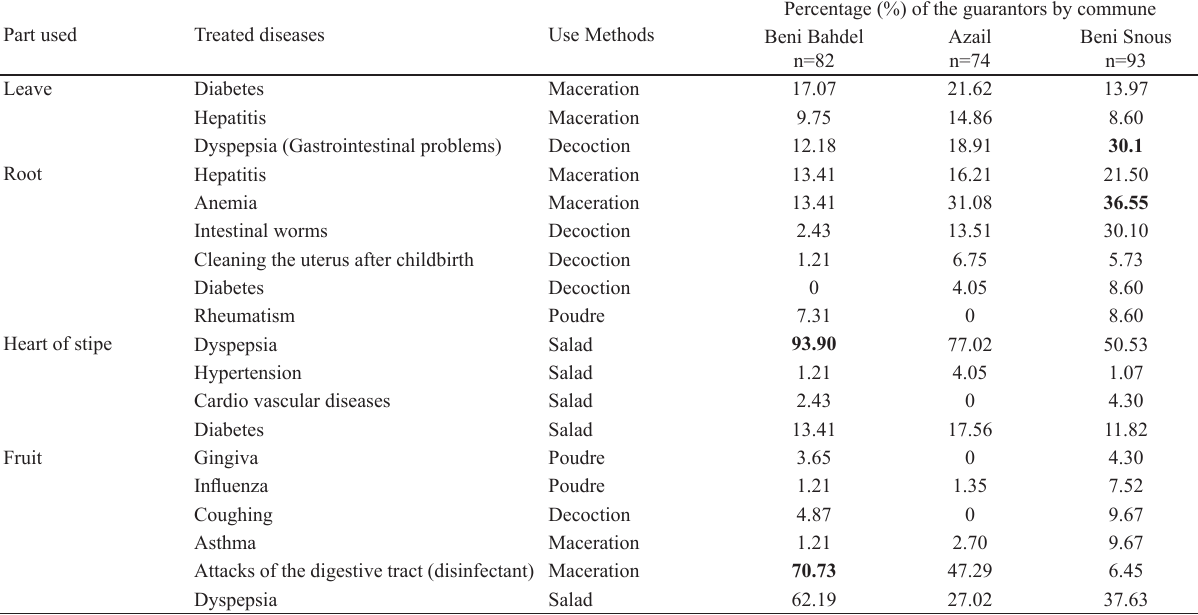
Table 4. Therapeutic importance of the various parts of Chamaerops humilis by municipality Part